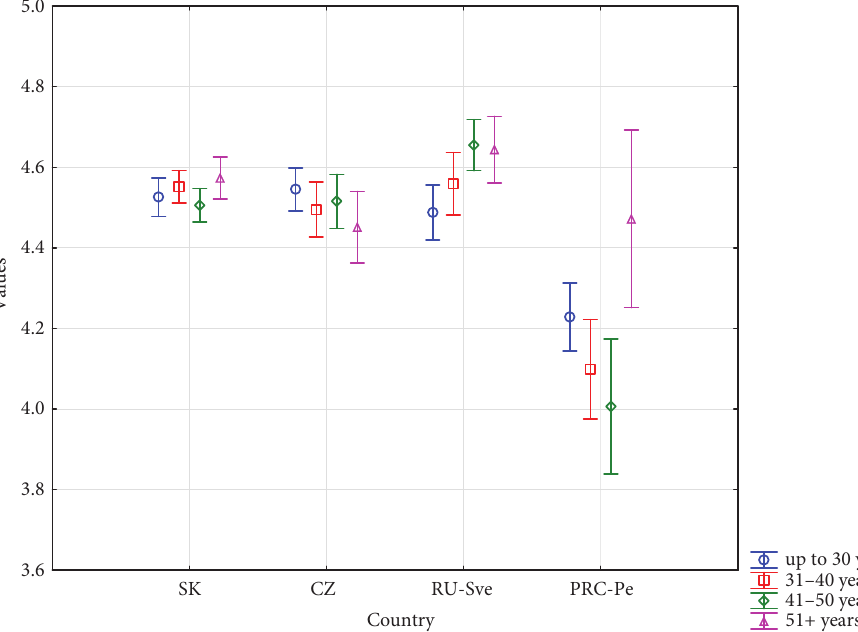
95% Reliability Interval: Atmosphere in the